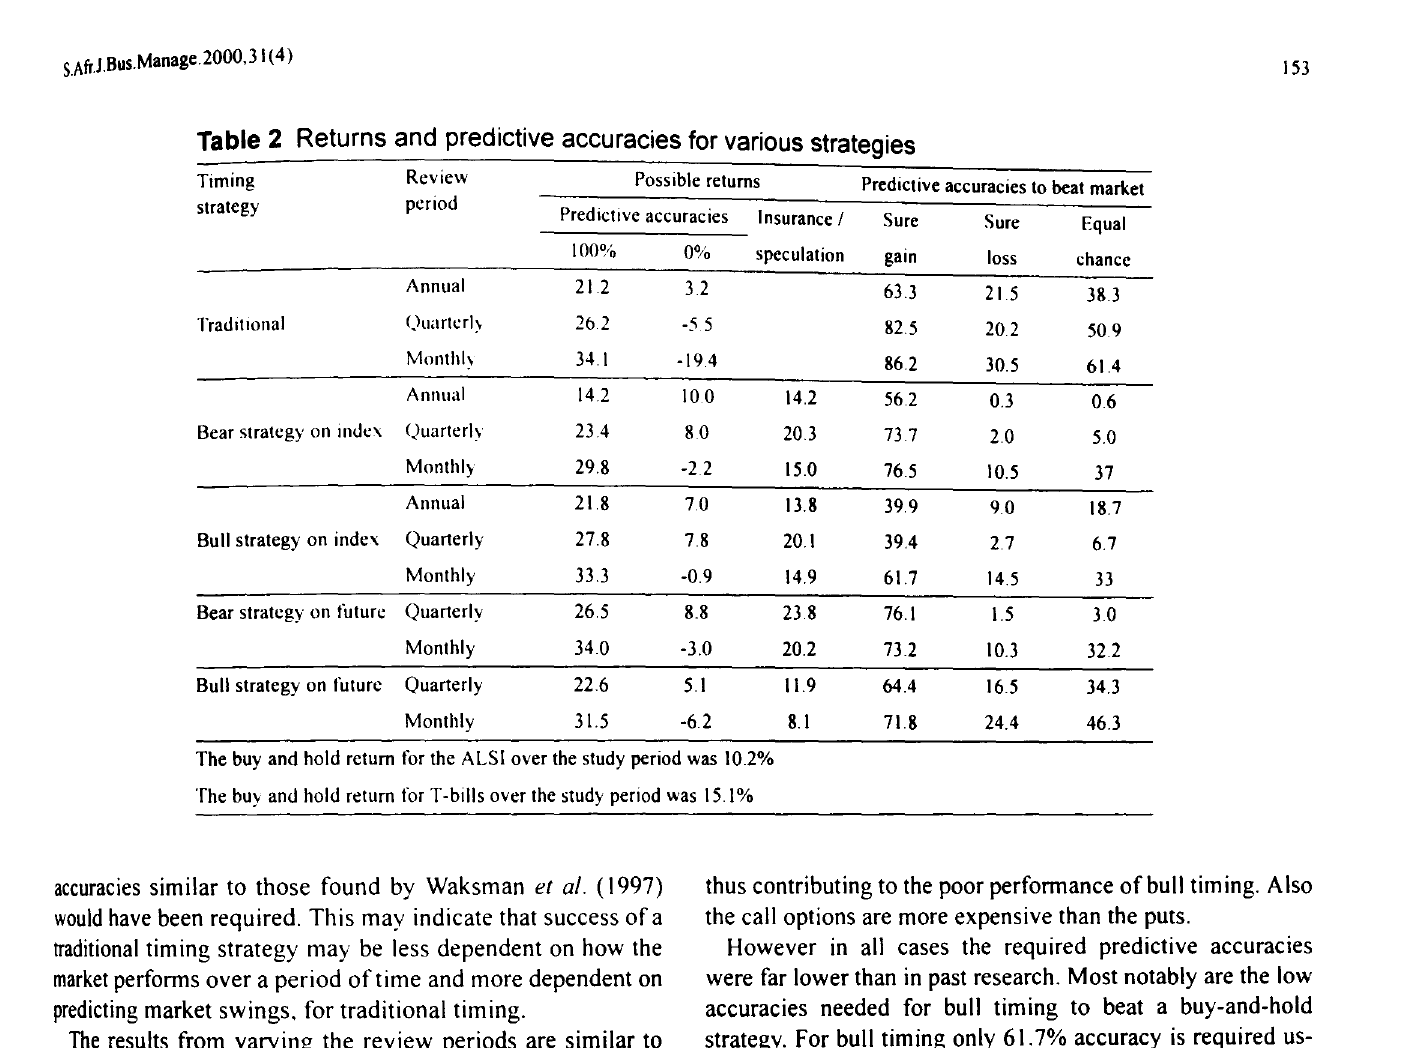
Bear strategy on mdc,